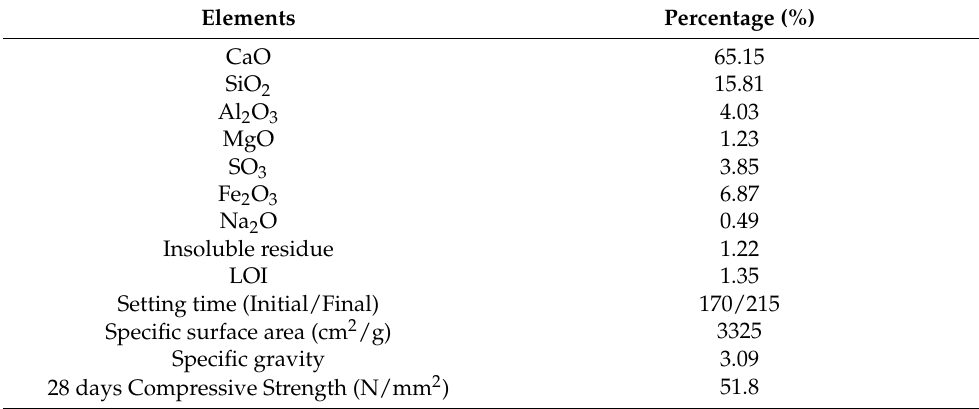
Table 1. Physico-chemical properties of